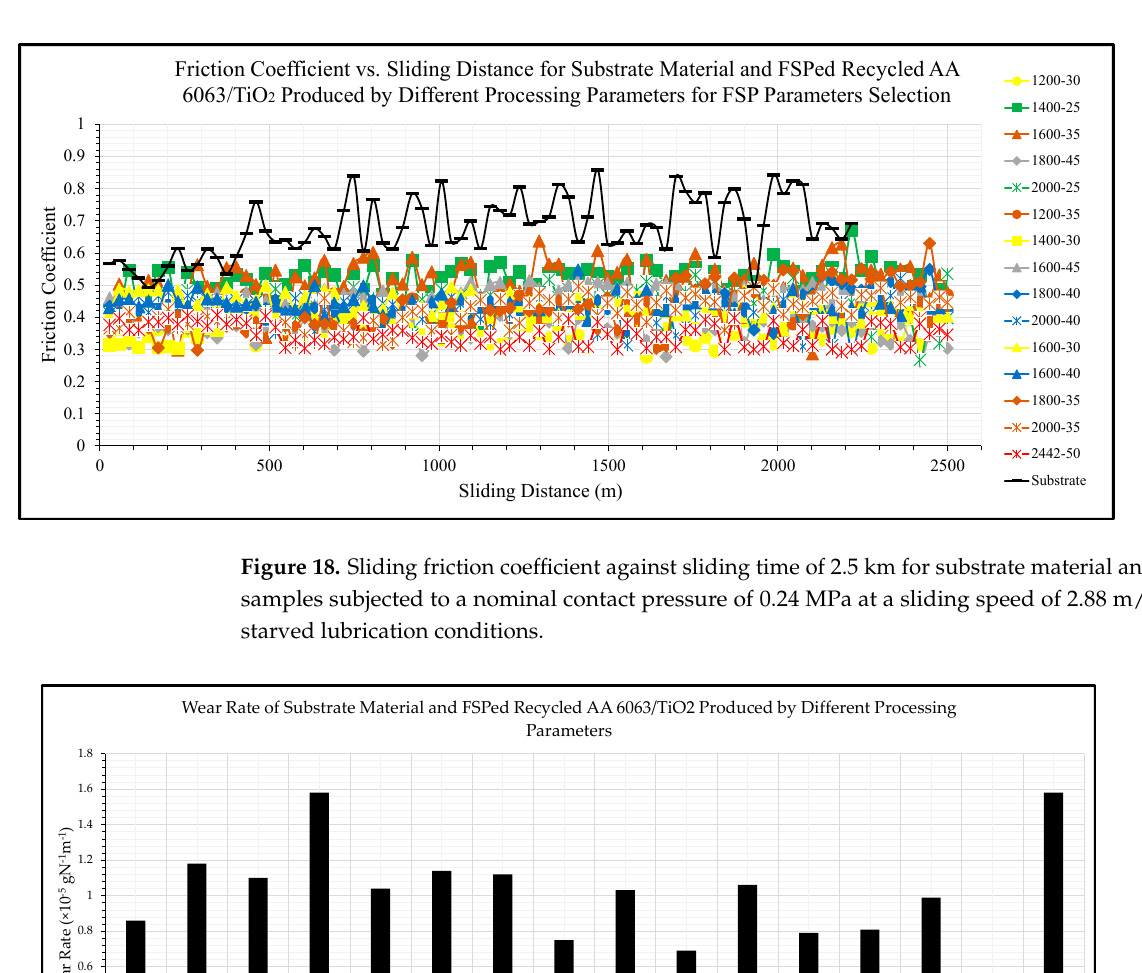
Friction Coefficient vs. Sliding Distance for Substrate Material and FSPed Recycled AA 6063/TiO 2 Produced by Different Processing Parameters for FSP Parameters Selection